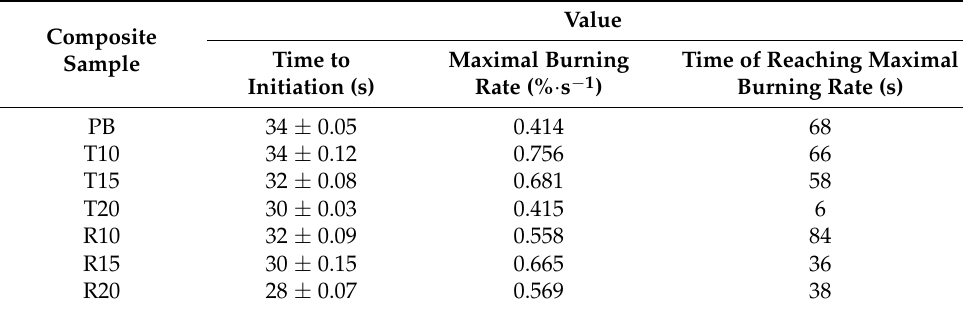
Figure 3. Absolute burning rate of the composite samples. Table 4. Values representing burning rate and burning time of the composite